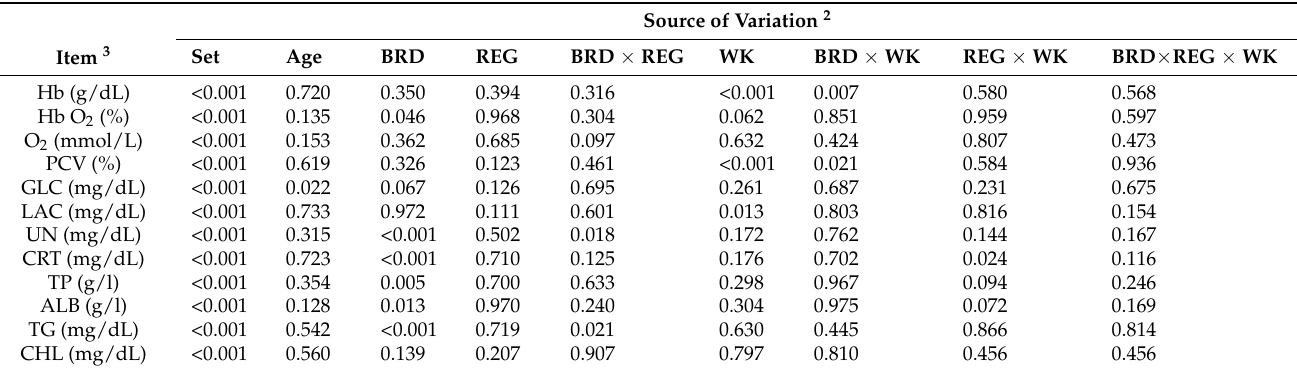
Table 6. p values for effects of breed, region, and week within period 4 on hemoglobin concentration and oxygen saturation, blood O 2 concentration, packed cell volume, and serum concentrations of glucose, lactate, urea nitrogen, creatinine, total protein, albumin, triglycerides, and cholesterol in hair sheep 1